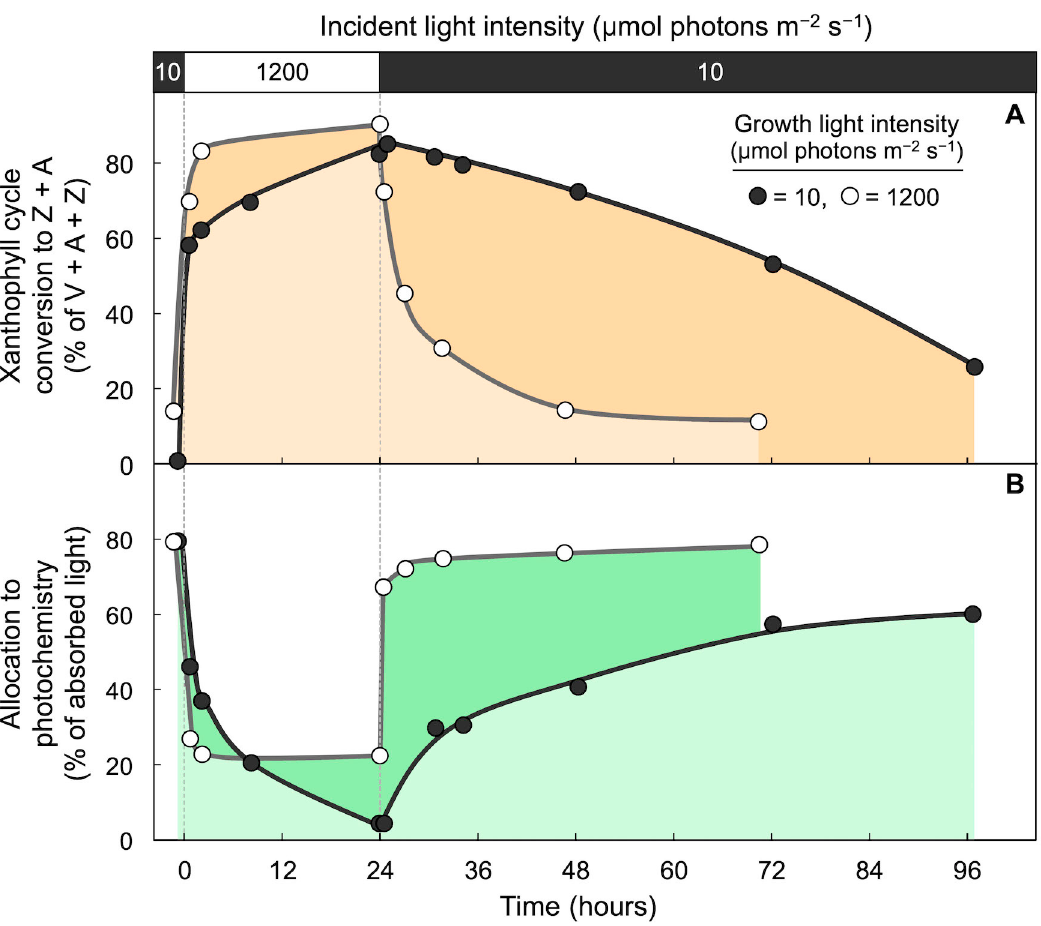
Figure 13. Impact of sudden transfer from low light (10 µmol photons m − 2 s − 1 ) to high light (1200 µmol photons m − 2 s − 1 ; open bar across top) for 24 h followed by return to low light (black bar across top) on leaves of Schefflera arboricola that developed in either low light (dark circles) or in high light in a greenhouse where leaves received a peak photon flux density of 1200 µmol photons m − 2 s − 1 (open circles). ( A ) Percent of xanthophyll cycle converted to zeaxanthin + antheraxanthin and ( B ) percentage of absorbed photons allocated to photochemistry (quantified from chlorophyll fluorescence as photosystem II efficiency). V = violaxanthin. Data are from Demmig-Adams et al. [73].